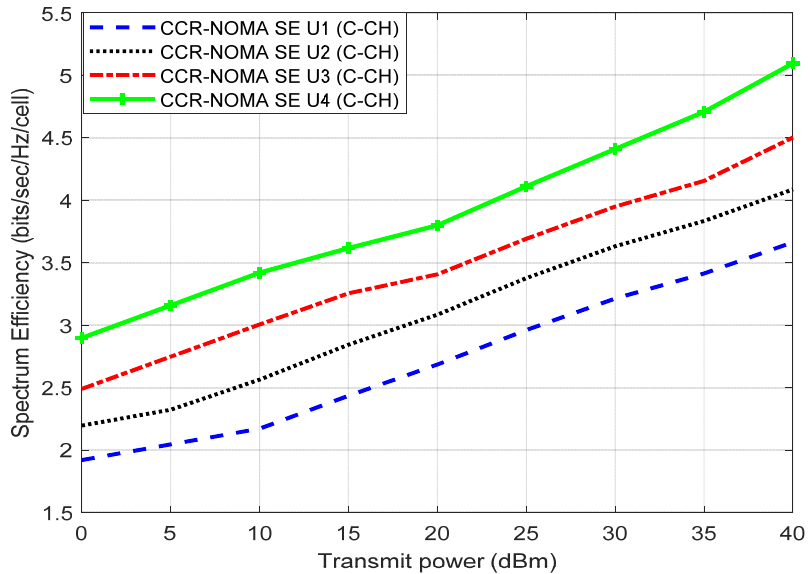
Figure 5. SE against transmitting power for 4 users’ SISO DL NOMA PD with C-CH CCRN. For SISO DL NOMA PD integrated with the CCRN with the D-CH (dedicated channel second model), the SE versus transmit power is demonstrated in Figure 6 for four users with various distances and power location coefficients. The greatest SE result is 7.2 bps/Hz/cell for U 4, at a transmit power of 30 dBm.